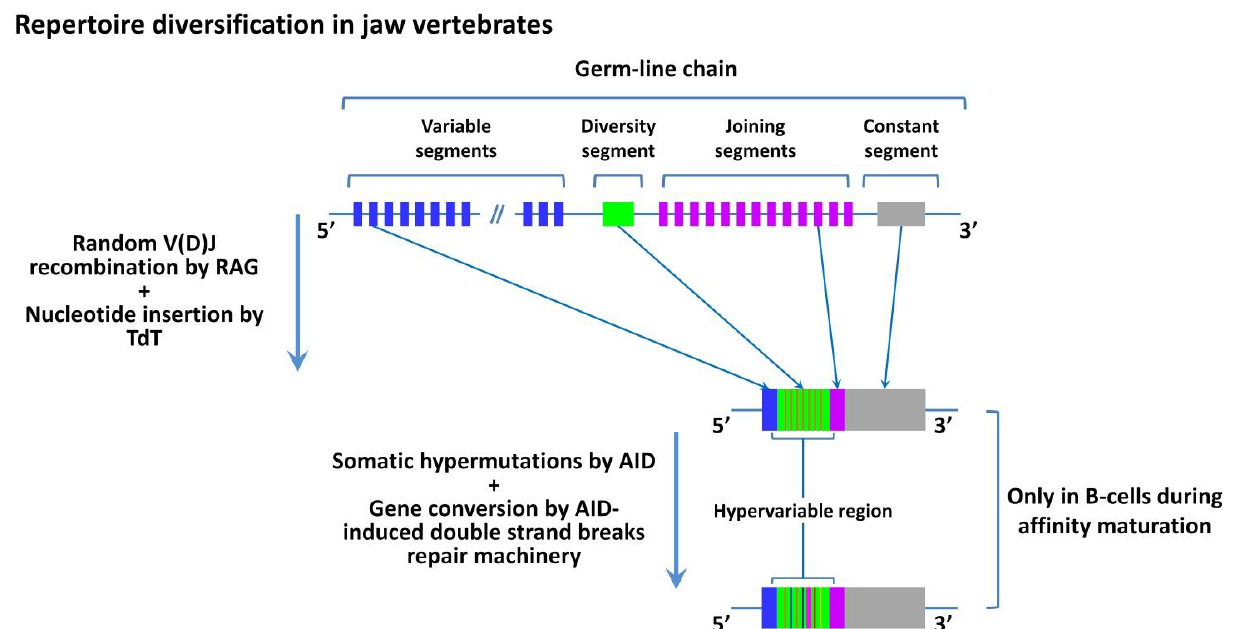
Figure 2. Diversification mechanism of antigen receptors (TCRs and BCRs) in jaw vertebrates. Somatic recombination is the mechanism of V(D)J segments recombination that occurs in maturating T- and B- lymphocytes at an early stage of development in the thymus and bone marrow, respectively. This process mediates by a protein complex led by the RAG protein that initiates random rearrangement of V, J, and D segments, which leads to the emergence of novel antigen-binding regions of TCRs and BCRs. An important role in repertoire diversification belongs to TdT, a template-independent DNA polymerase that randomly adds non-template nucleotides to the coding-end of an open hairpin, thereby forming an N-insert immediately after the P-insert formation. Further reorganization of the variable region is possible only in B cells during the process of somatic hypermutations that mediate by AID in the course of affinity maturation. This process relies on the gene conversion-like mechanism during the reparation of double-strand DNA breaks. RAG, recombination-activating gene; TdT, terminal deoxynucleotidyl transferase; AID, activation-induced deaminase. The illustration is not drawn to scale.